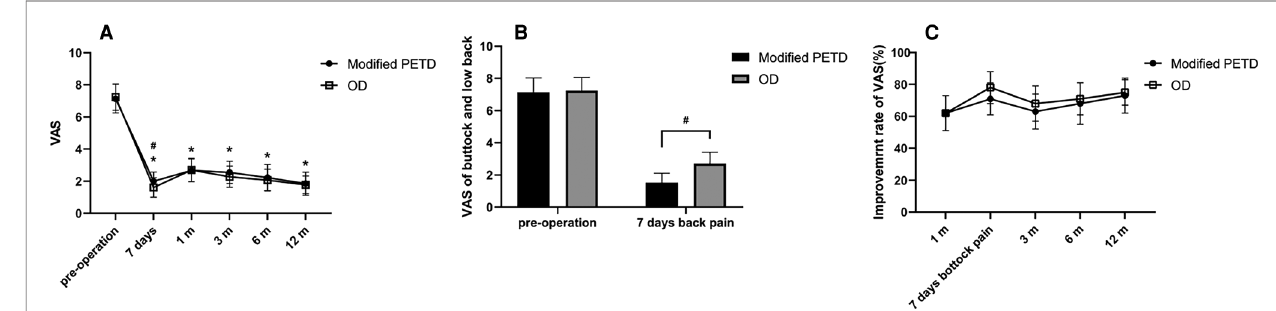
FIGURE 5 | VAS score outcome values ( A ), VAS score outcome values for low back pain at 7 days postoperatively ( B ), and VAS score improvement rate ( C ). * indicates statistical signi fi cance compared within groups ( P <0.01), # indicates statistical signi fi cance compared between groups (